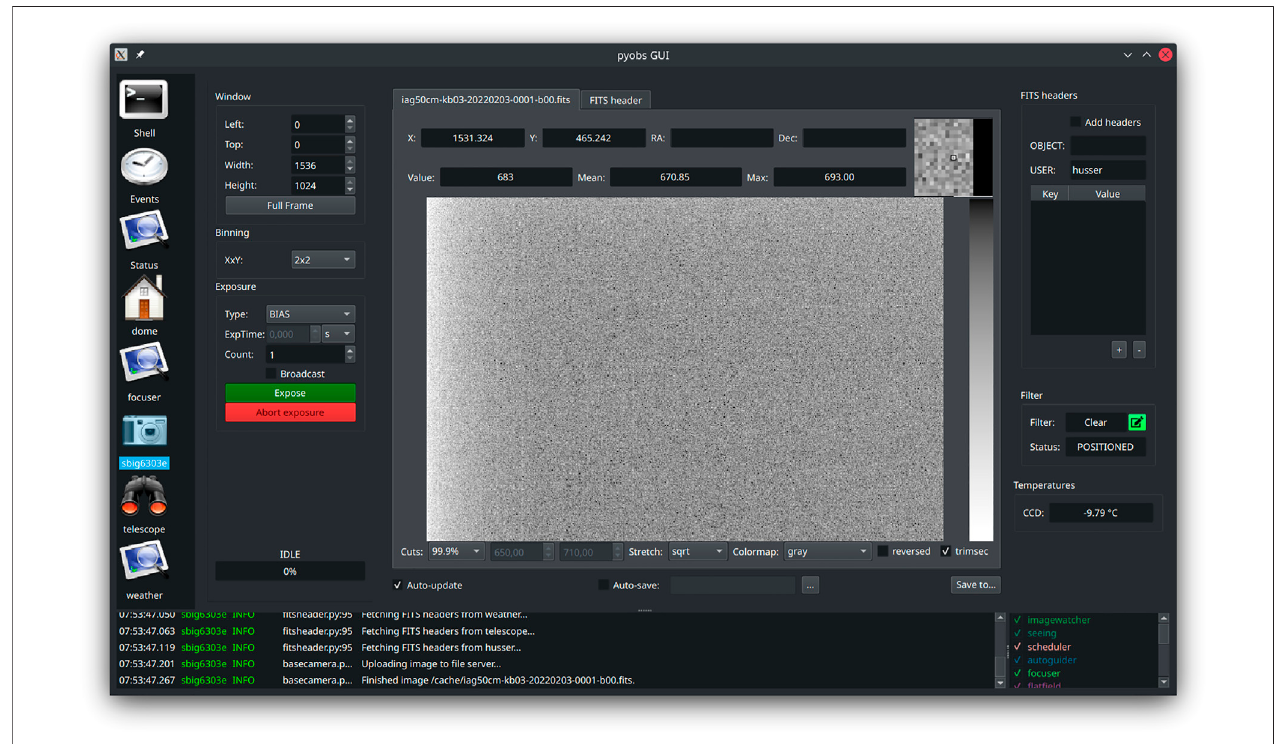
FIGURE 5 | A screenshot of the graphical user interface (GUI) as provided by pyobs-gui. It shows the list of connected modules that are supported by the GUI on the left. When selecting one, a custom widget for each kind of module is shown in the main area right of it. Below is the logging area, which shows log entries from all connected